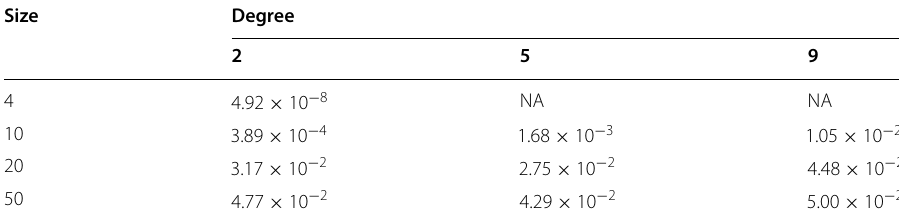
Table 6 Minimum recovery RMSE by degree and size Size